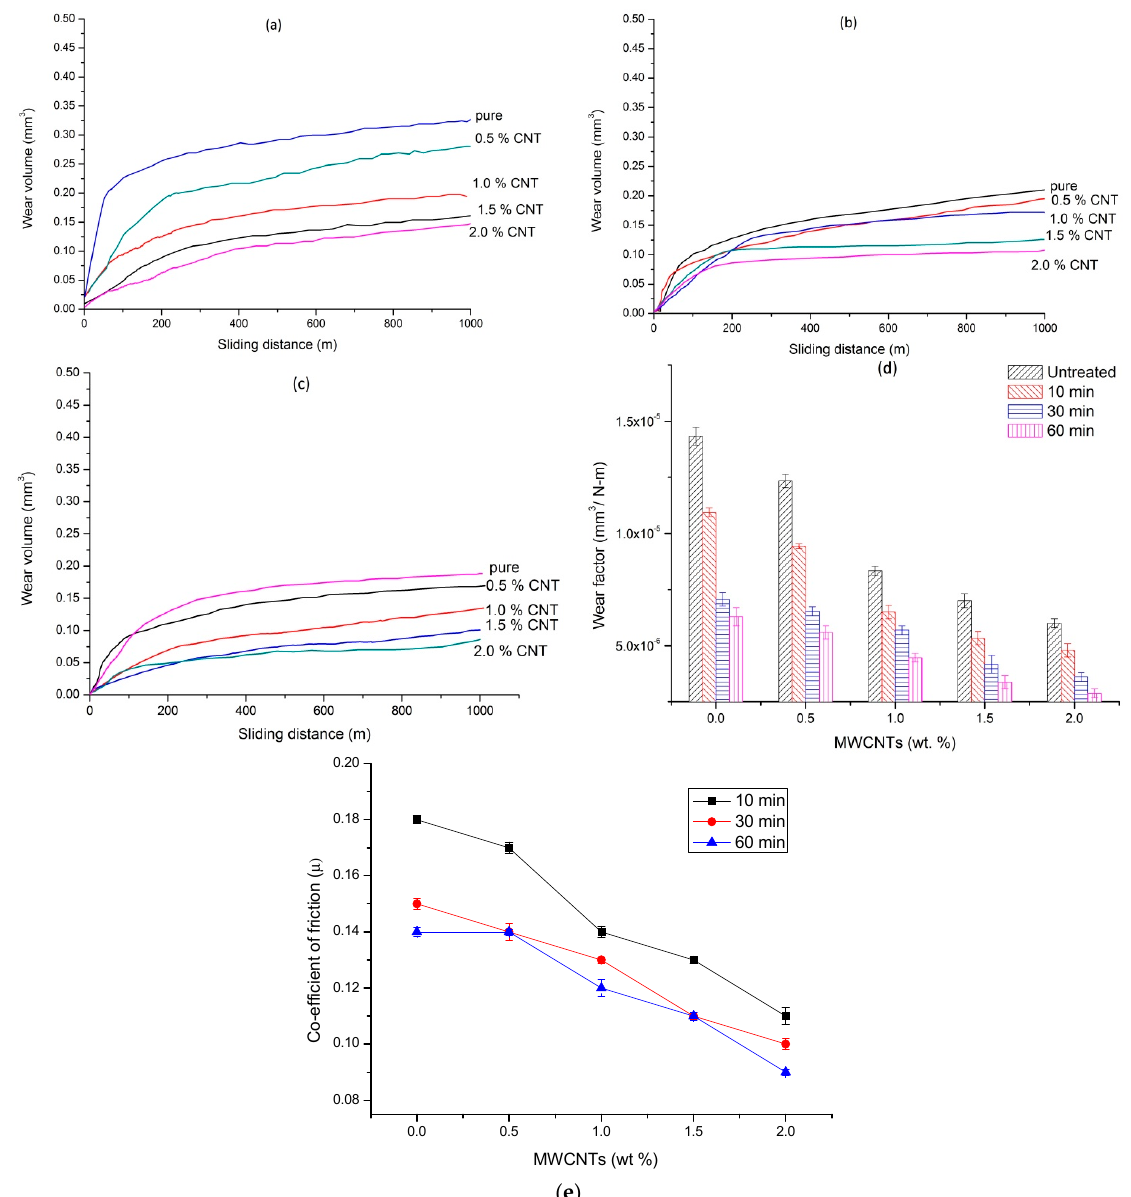
Figure 6. The sliding distance vs. wear volume of plasma-treated samples ( a ) 10 min; ( b ) 30 min; ( c ) 60 min; ( d ) wear factor; and ( e ) coefficient of friction, under N-Saline lubricant conditions.